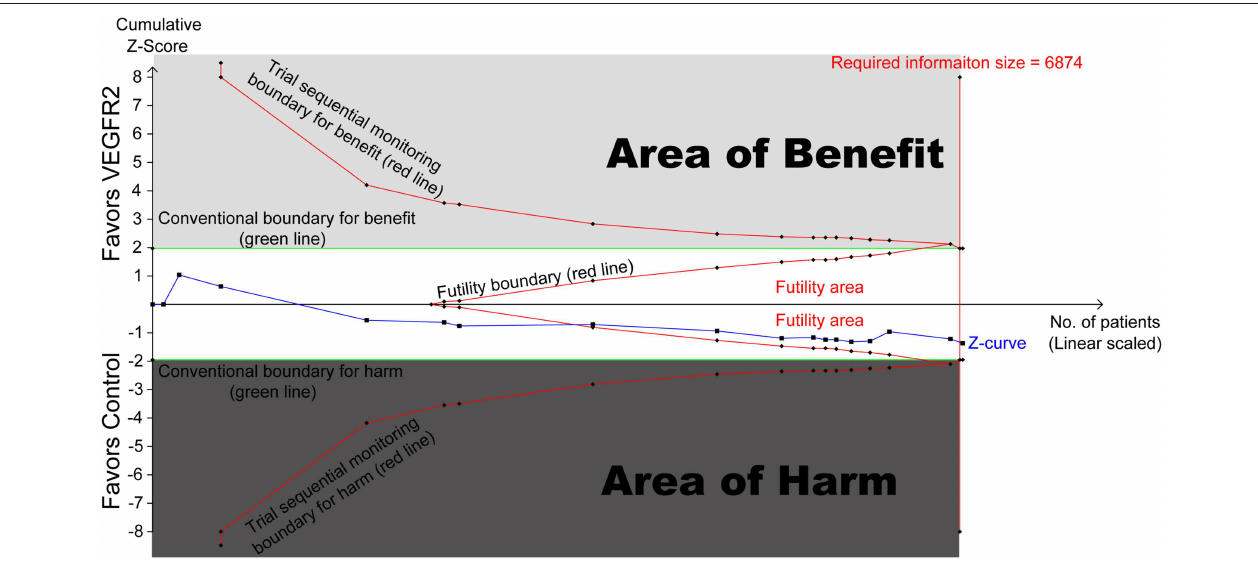
FIGURE 3 | Trial sequential analysis (TSA) of 17 RCTs comparing VEGFR2-targeted agents with control (scaled trial distance). A diversity-adjusted required information size of 6,874 patients was calculated using α = 0.05 (two-sided) and β = 0.20 (power of 80%), an anticipated relative risk reduction of 20% in the control arm. TSA of 17 trials (black filled squares) demonstrating that the cumulative z curve crossed the futility boundary and required information size line, establishing conclusive and sufficient evidence and suggesting no further trials are needed. X axis, number of patients randomized; Y axis, cumulative z score; horizontal green dotted lines, conventional boundaries (z score, ± 1.96; two-sided p = 0.05); Sloping red lines with black filled circles, trial sequential monitoring boundaries; blue line with black filled squares, z curve; vertical red line, required information size; upper light-gray rectangle, area of benefit; lower dark-gray rectangle, area of harm; middle white rectangle, futility area.